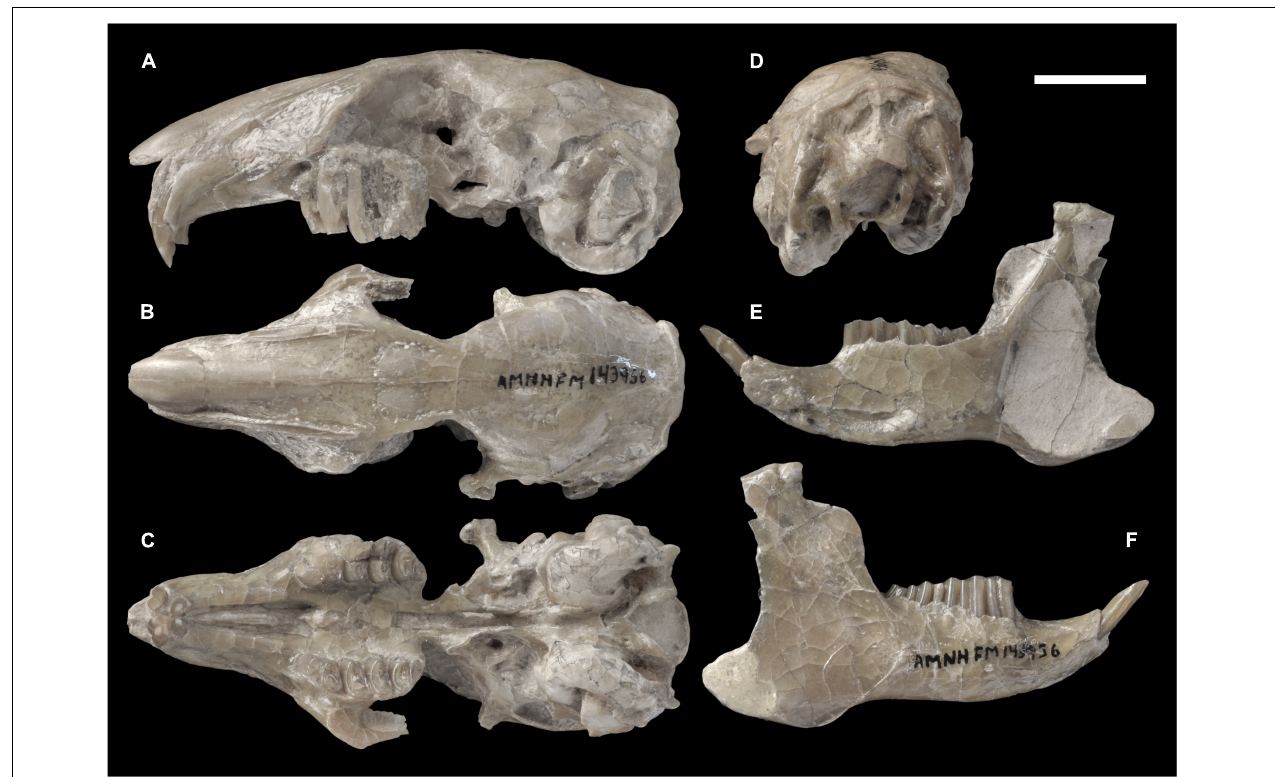
FIGURE 2 | Skull of Palaeolagus haydeni (AMNH FM143956) from the early Oligocene of Wyoming in (A) left lateral, (B) dorsal, (C) ventral, and (D) posterior views. Mandible of the same specimen in (E) medial and (F) lateral views. Note the well-preserved nasal region and the completely preserved mandible. Scale bar = 10